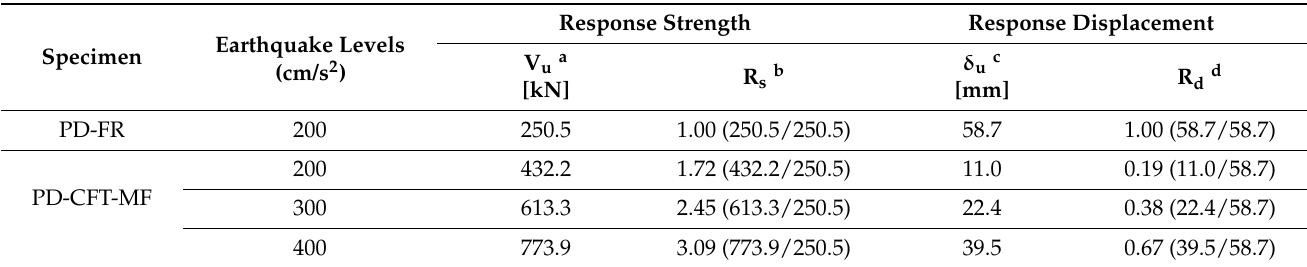
Table 5. Comparison of maximum seismic response load-displacement results and corresponding seismic response strength and displacement